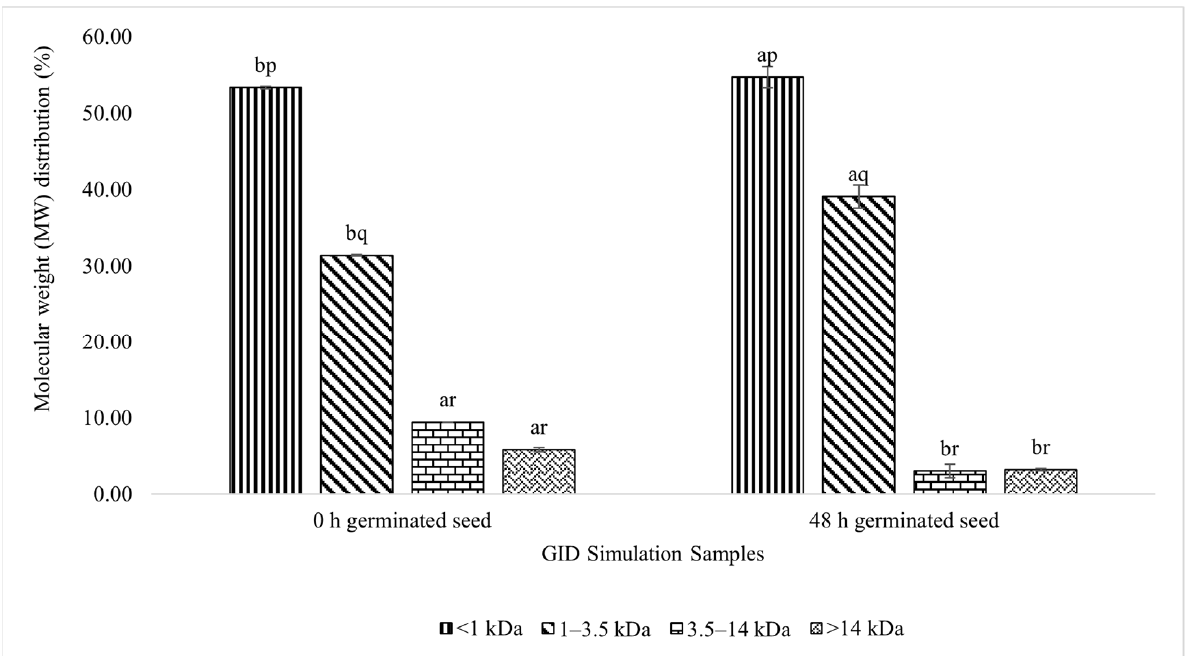
Figure 4. MW distribution of the germinated lamtoro gung flour peptide in different fractions after the GID simulation. Values are means with their SDs. a and b letters indicate significant differences between the same peptide fraction in different samples ( t -test, α = 0.05). p, q, and r indicate significant differences between the different peptide fractions in the same sample (Duncan’s test, α = 0.05).